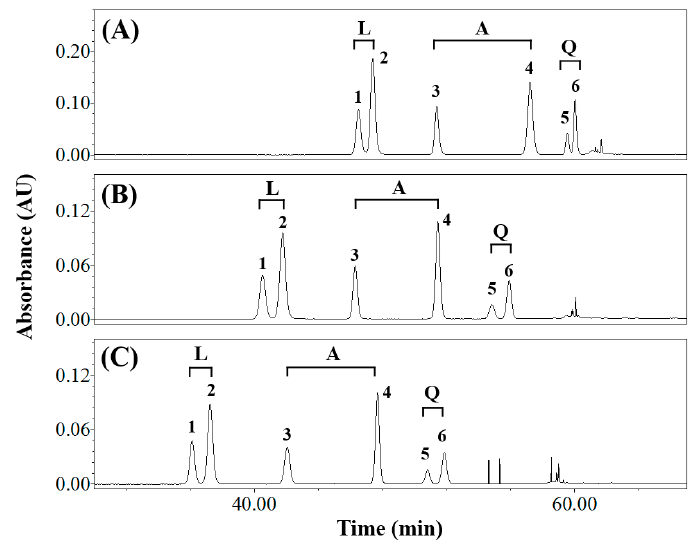
Figure 2. Reversed-phase HPLC traces of common buckwheat sprout extract acquired at flow rates of: ( A ) 0.6 mL min − 1 , ( B ) 0.8 mL min − 1 , and ( C ) 1.0 mL min − 1 detected at 360 nm. Peak number: 1,